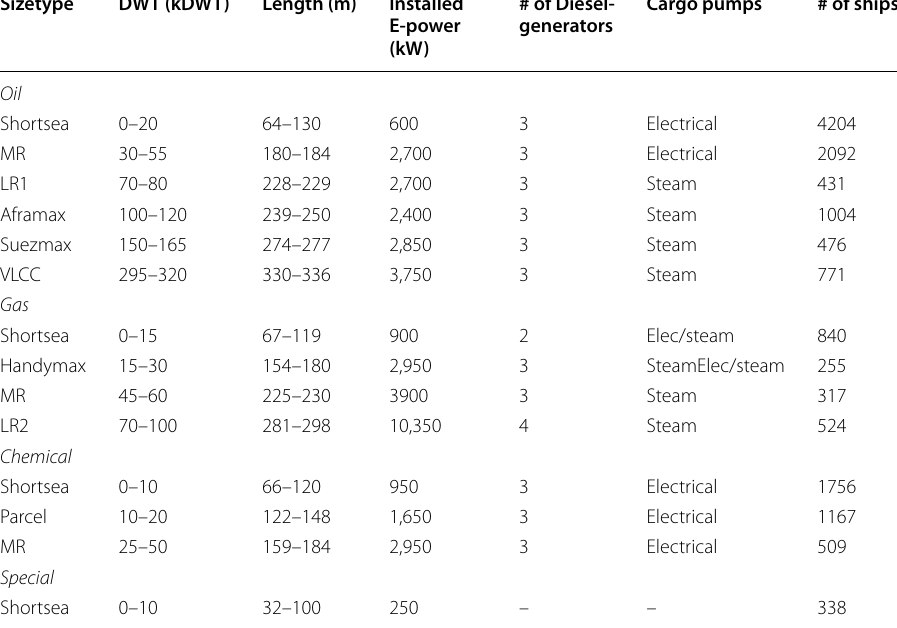
Table 2 Overview of key ship type attributes for shore power. Source : Authors, based on information from (Clarkson 2021; UNCTAD